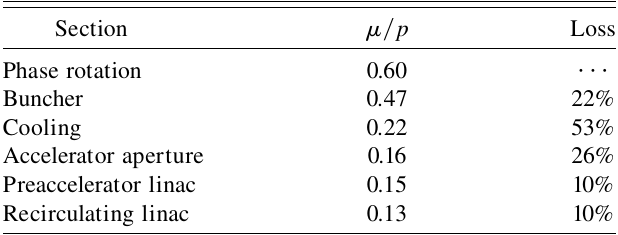
TABLE XII. Muon survival and losses in several sections of the study-II neutrino factory. (cid:3)=p is the number of muons per proton at the end of that section, and ‘‘Loss’’ is the loss in that